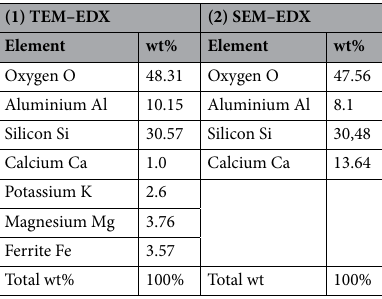
Table 1. Energy dispersive analysis of X-rays (EDX) of the newly explored SHNTs: (1) TEM–EDX, (2) SEM–